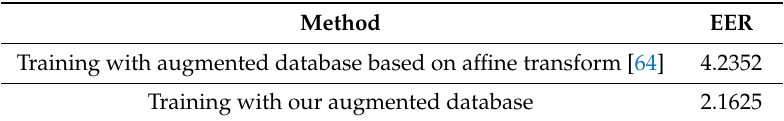
Table 12. Comparative EERs on CASIA-Iris-Distance database in case of training with augmented database based on affine transform [64] with our augmented database (unit: %).